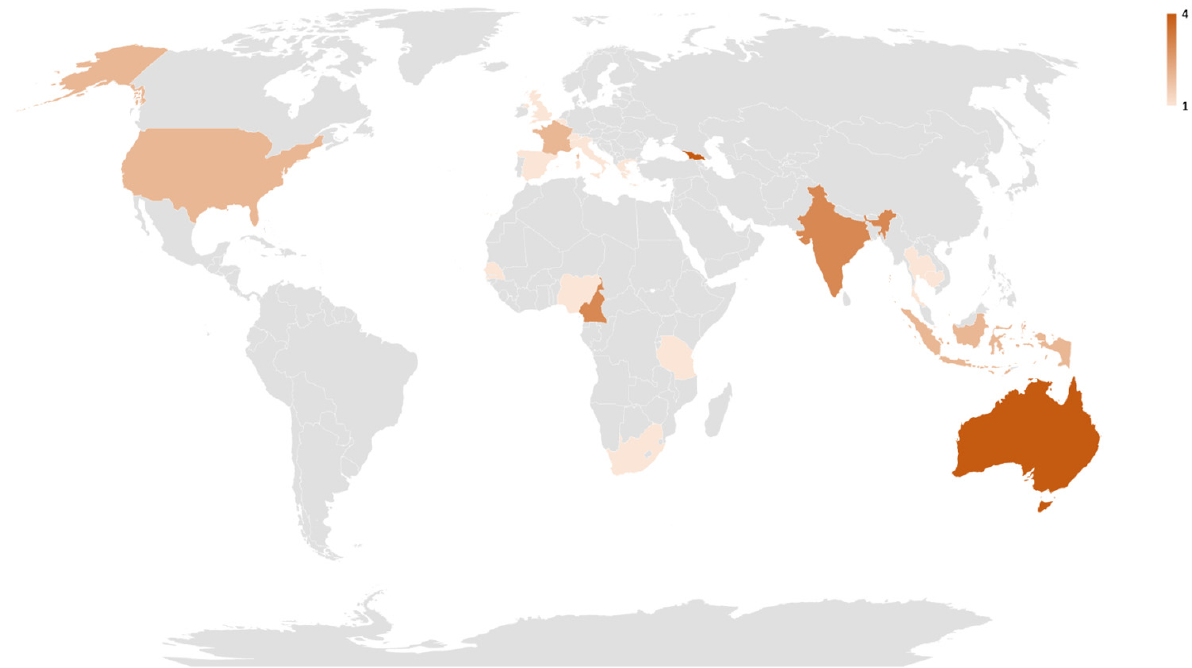
Figure 2. Geographic distribution of countries from 25 studies included within the review (shaded in red). WHO regions: Africa —Cameroon ( n = 3), Nigeria ( n = 1), Senegal ( n = 1), South Africa ( n = 1), and Tanzania ( n = 1) . Americas —the United States ( n = 2) . Europe —Belgium ( n = 1), France ( n = 2), Georgia ( n = 4), Greece ( n = 1), Italy ( n = 1), Spain ( n = 1), Switzerland ( n = 1), UK ( n = 1), and Ukraine ( n = 2) . South-east Asia —India ( n = 3), Indonesia ( n = 2), and Thailand ( n = 1) . West Pacific —Australia ( n = 4), Cambodia ( n = 1), and Malaysia ( n = 1).